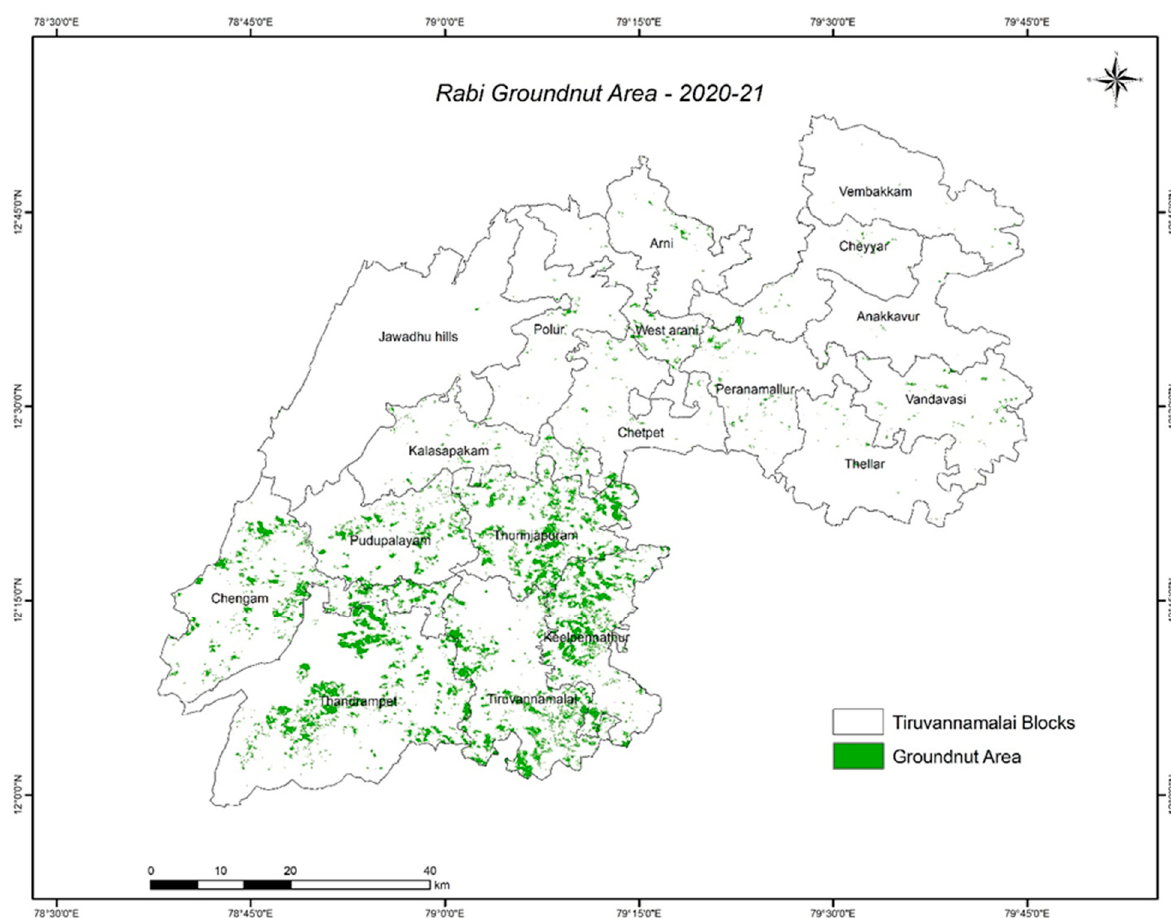
Figure 7. Peanut area of Tiruvannamalai district during Rabi 2020–2021. Table 1. Peanut area divided in blocks for the Tiruvannamalai district of Tamil Nadu during Rabi 2020–2021.